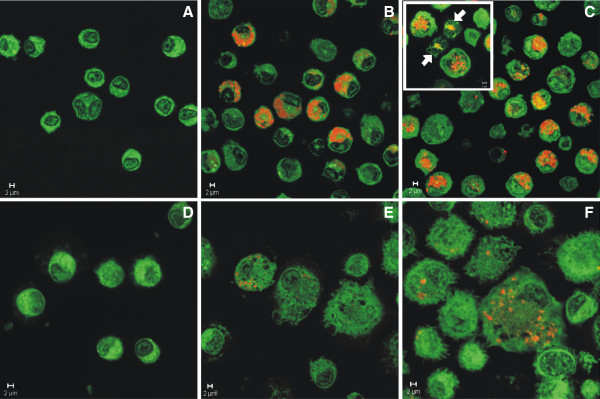
Confocal evaluation of AM uptake of QD in vivo. Confocal micrographs (63x-zoomed or 100x objective) of AM from the BAL of rats 1 (A-C) and 28 (D-F) days after intratracheal instillation with 12.5 μg QD-NH2 or QD-COOH (red/yellow), or PBS (control): (A) control – 1 day post-exposure, (B) QD-NH2 - 1 day post-exposure, (C) QD-COOH – 1 day post-exposure, (D) control – 28 days post-exposure, (E) QD-NH2 - 28 days post-exposure, and (F) QD-COOH – 28 days post-exposure. AM are green and QD are yellow/red. PMN uptake of QD is shown in the smaller inset micrograph in panel C (arrows).